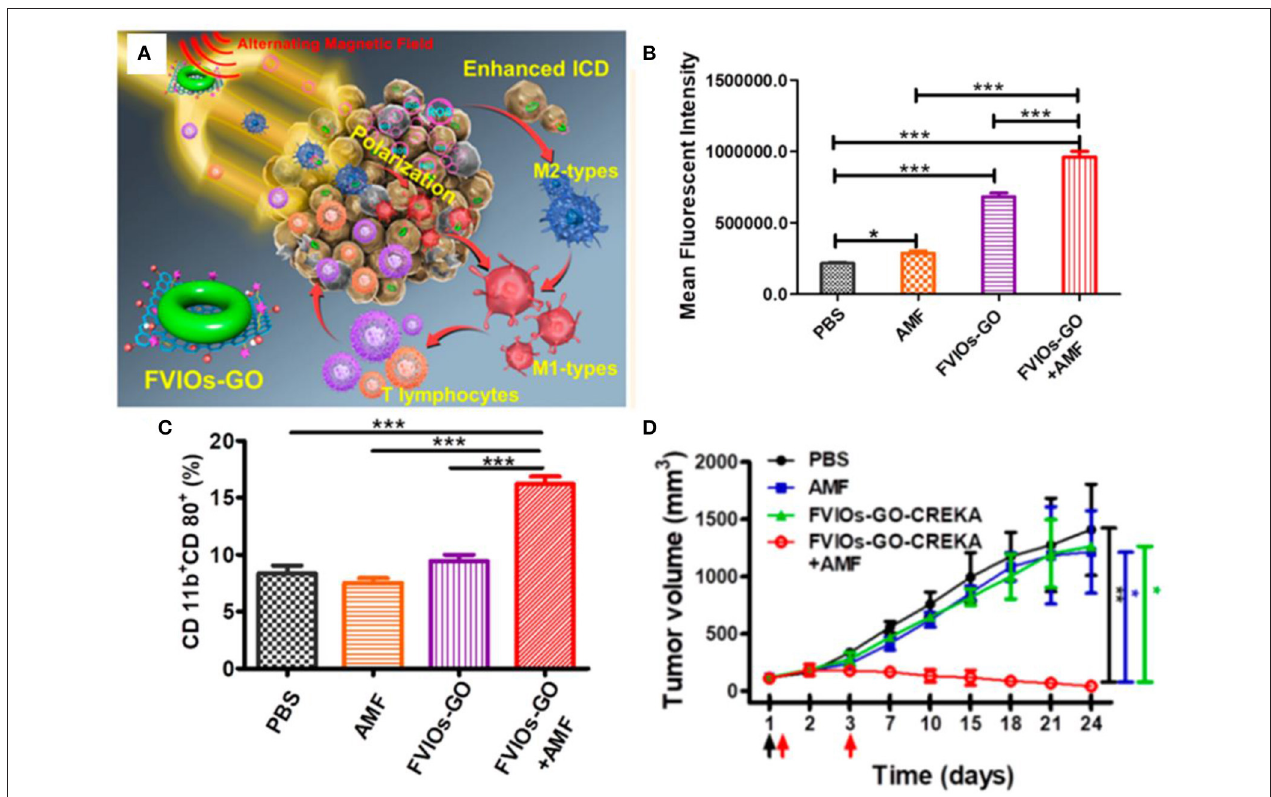
FIGURE 9 | (A) Schematic illustration for FVIOs-GO-mediated MTD by combination of a heating effect and ROS-related immunologic effect. (B) Quantification of ROS generation of 4T1 breast cancer cells. (C) Quantification of M1 macrophages for treatments. (D) Tumor volume vs. days after treatments. *0.01 < P < 0.05 ; **0.001 < P < 0.01 ; *** P < 0.001. Reproduced, with permission, from Liu et al. (2020). Copyright 2020, American Chemical